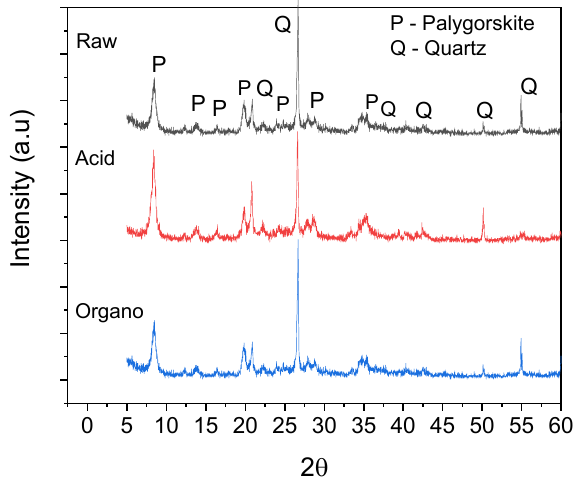
Figure 1. X-ray diffraction (XRD) pattern of raw and functionalized palygorskite.